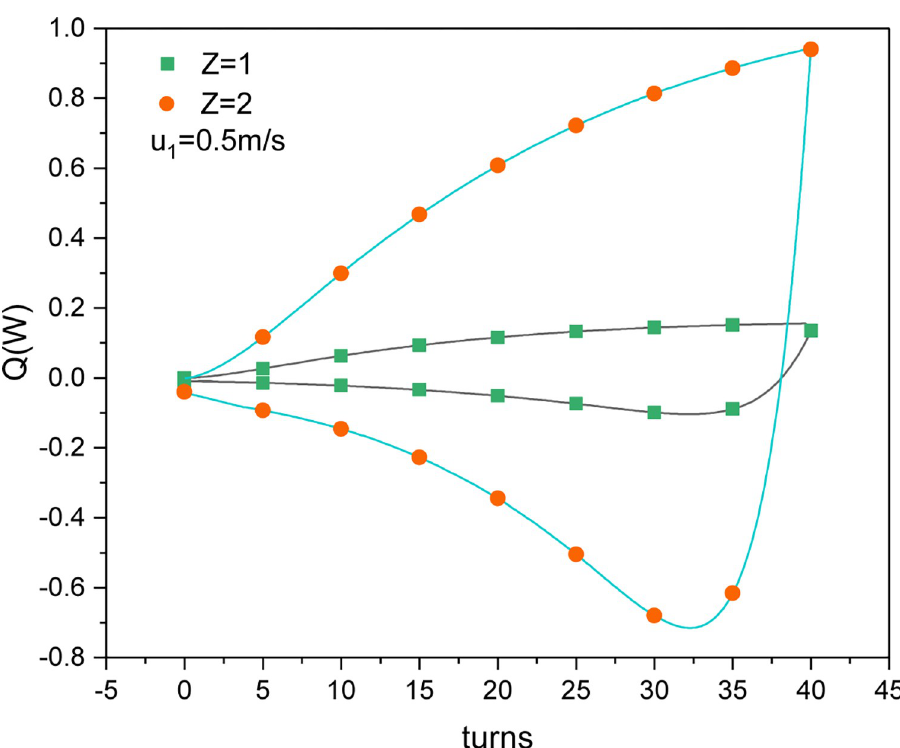
Fig 12. Changes in the simulated cooling and heating capacities of a nitinol wire-stepping motor unit.